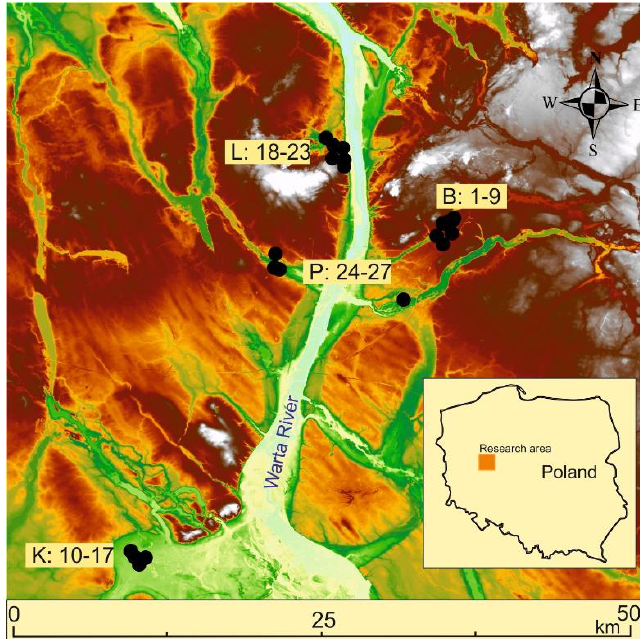
Figure 1. Location of the study plots in the background of the hypsometric map. The succession of colors reflects the relief from the highest places (white), through brown, yellow, to the lowest places marked in green (river valleys) and in light blue (rivers). Abbreviations of forest districts: B (Babki); K (Konstantynowo); L (Łopuchówko); P (Poznań Communal Forests). Coordinates of the study plots are placed in the Table 1.